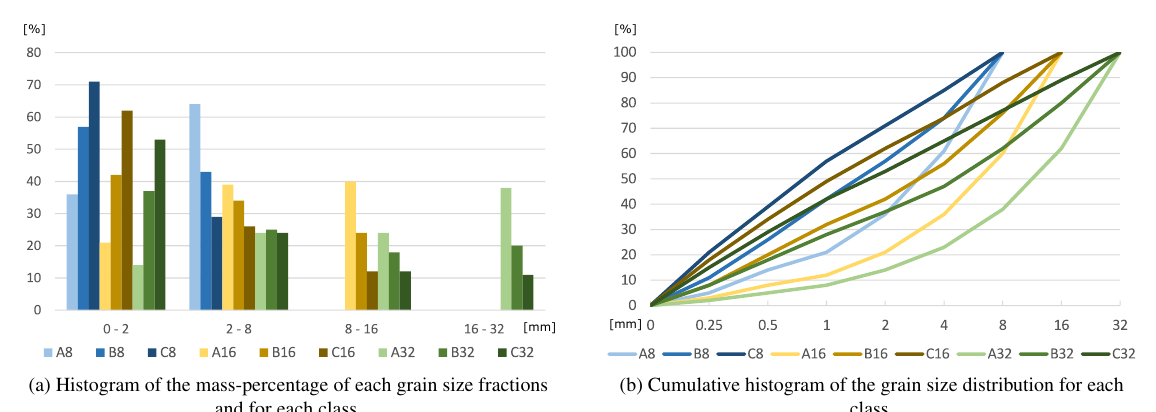
Figure 4. Quantitative definition of the nine grading curve classes which are distinguished in this work (vertical axes represent the mass-percentages of the grain size distribution).